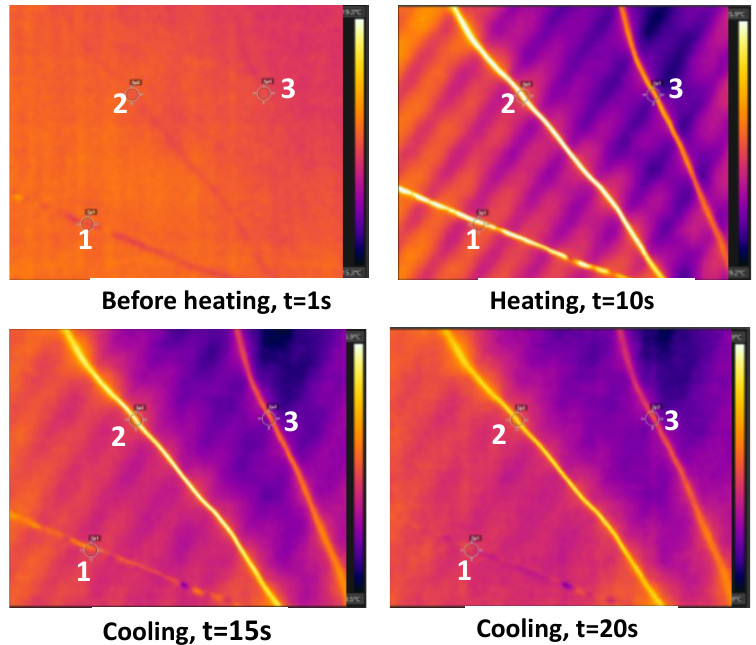
Figure 4. The infrared images of the three Litz wires (labelled 1, 2 and 3) from a bundle during heating and cooling. The wires labelled as 1 had their enamel completely removed, wire 2 had a coating of enamel on the surface, and wire 3 had its enamel coating partially removed.